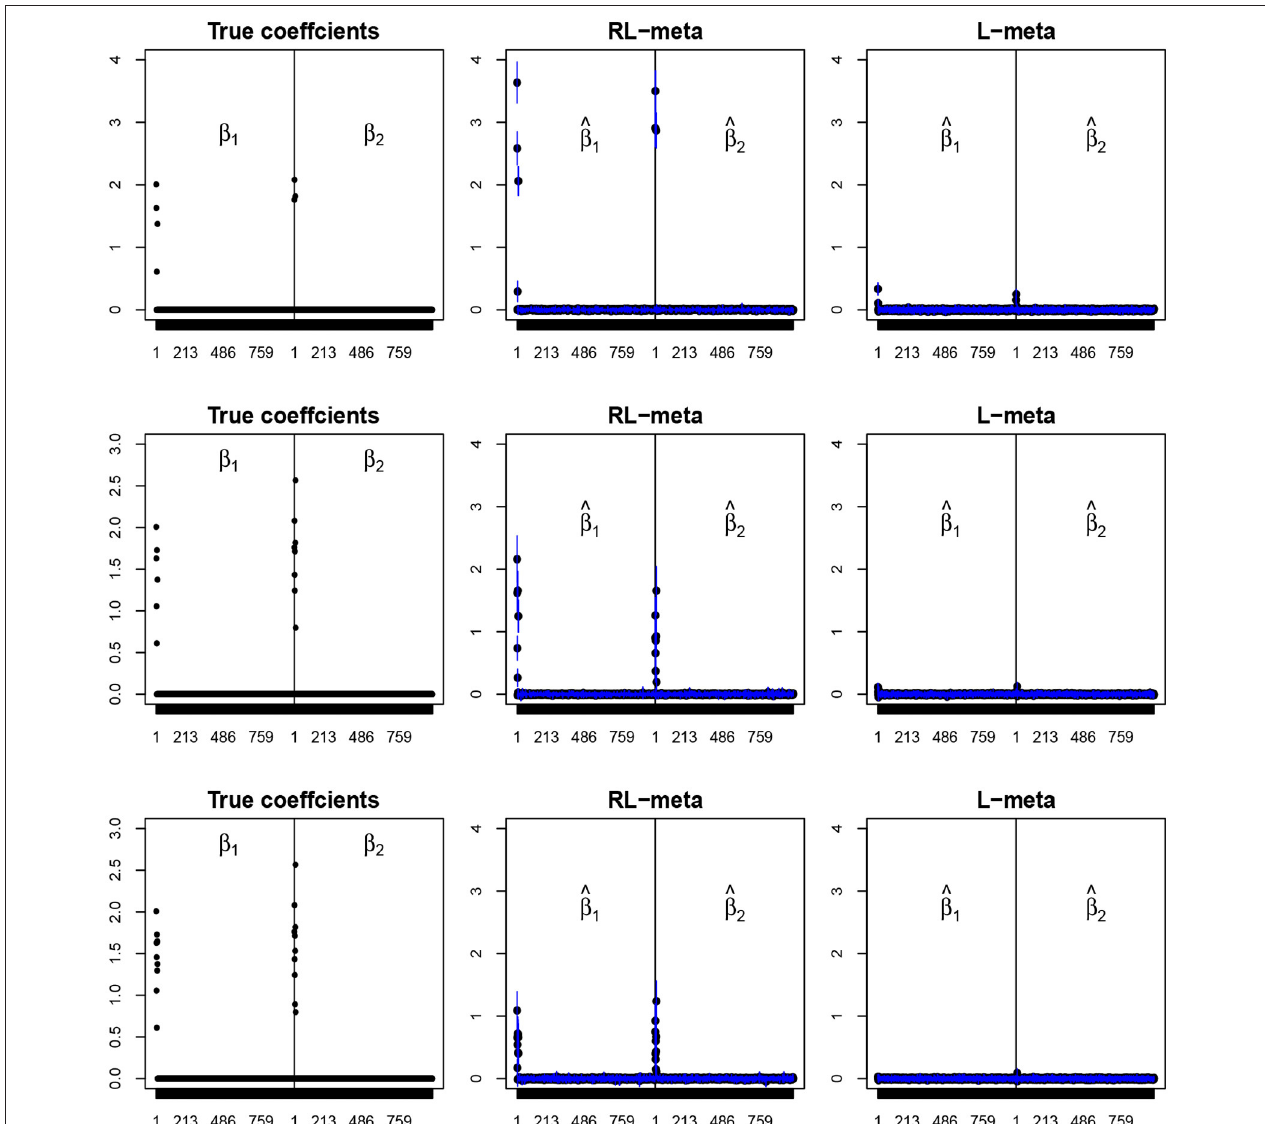
FIGURE 5 | The coefficient estimates with contamination data for M = 2 and ( n , p ) = (150,1,000). The blue points and lines represent the estimated values and the interval estimates of coefficients over 100 simulations. Rows from top to bottom correspond to π = 0.2,0.5,0.9, respectively.